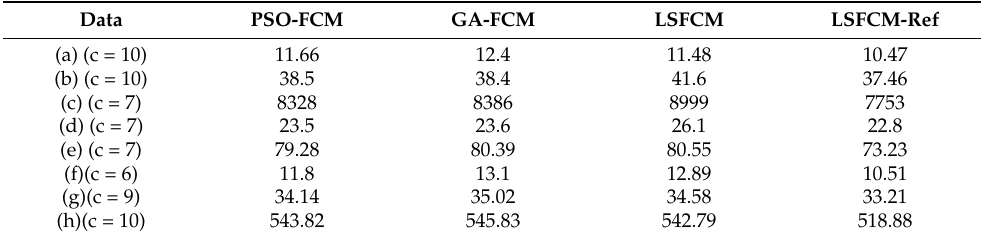
Table 2. Comparison with other FCM models.